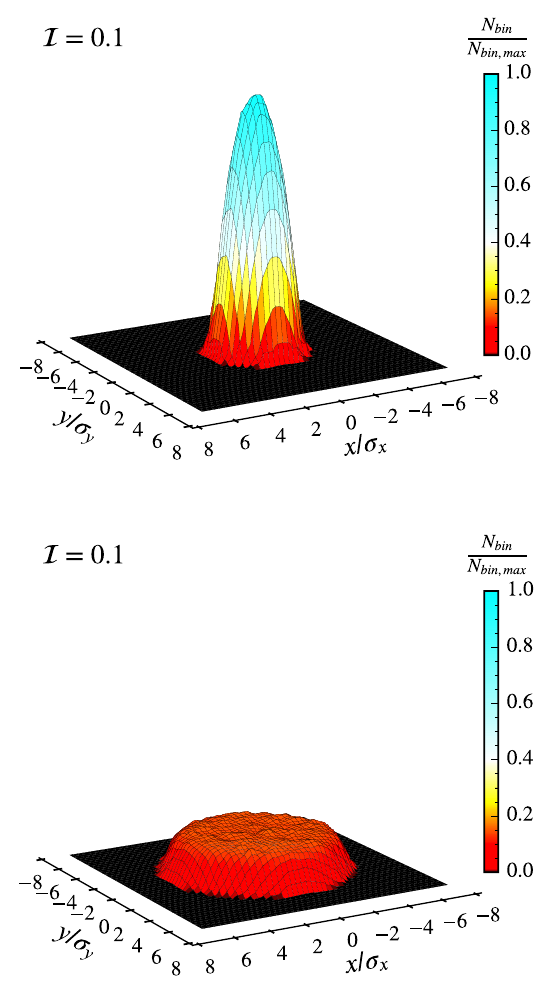
FIG. 1. Awater bag beam is rms matched to a uniform focusing structure, and its intensity is strong enough to create a Debye length smaller than the rms beam sizes. The picture on top shows the initial particle distribution. The picture on the bottom shows the particle distribution at an instant during transport. It is visible that the “ type ” of beam distribution has changed from WB to uniform, highlighting a space-charge-driven collective dynamics of particles in the beam. Both histograms are normalized with the maximum bin particles of the initial particle